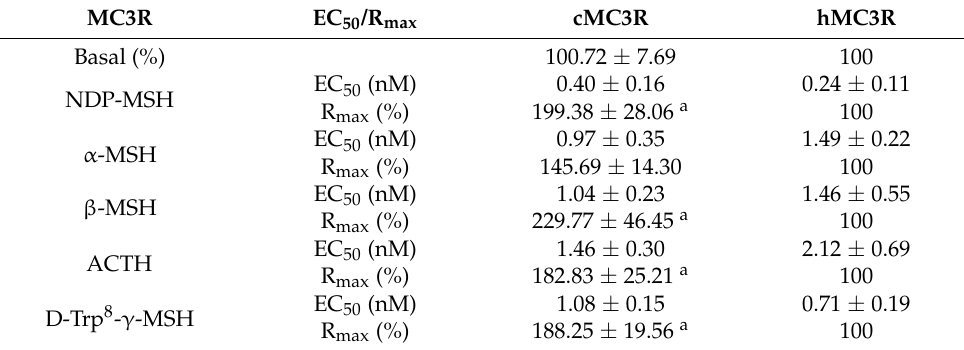
Table 2. The signaling properties of